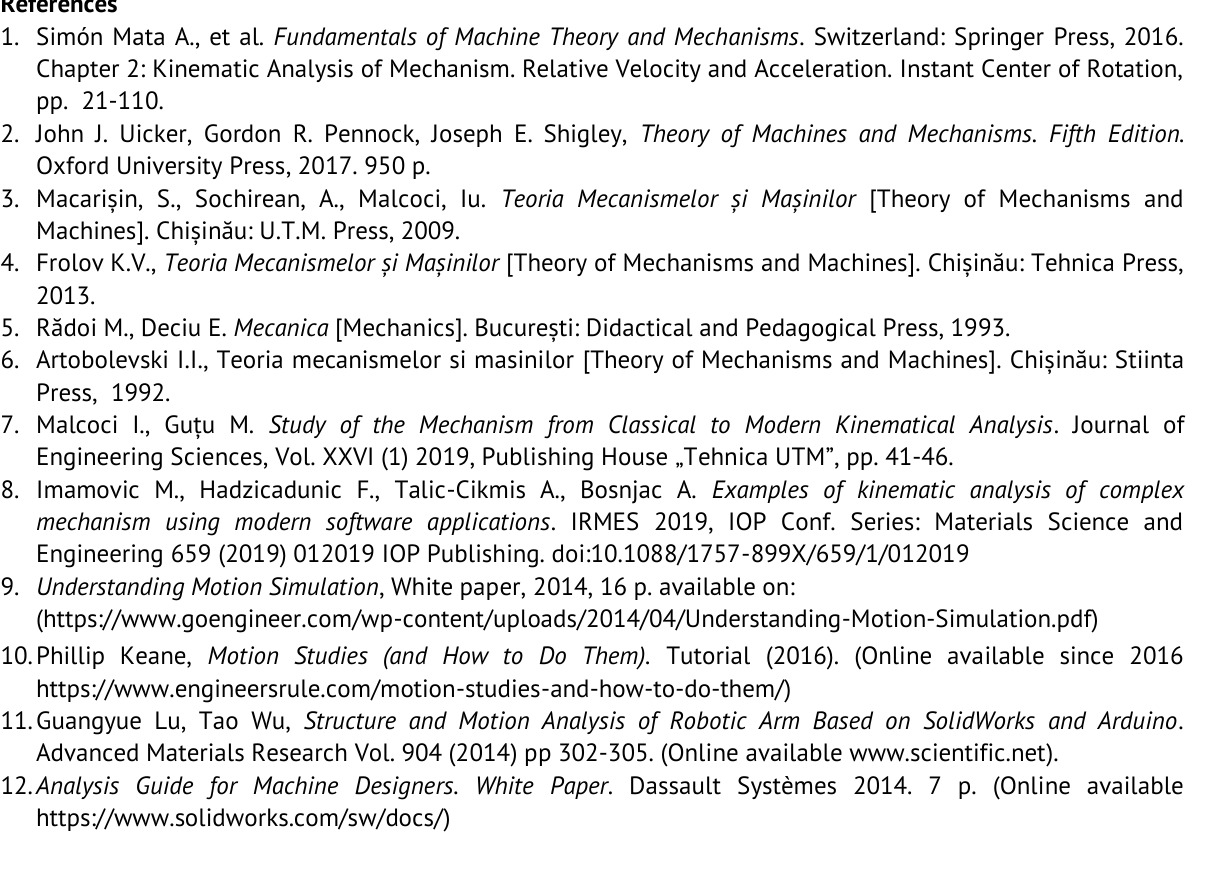
) angular acceleration 4